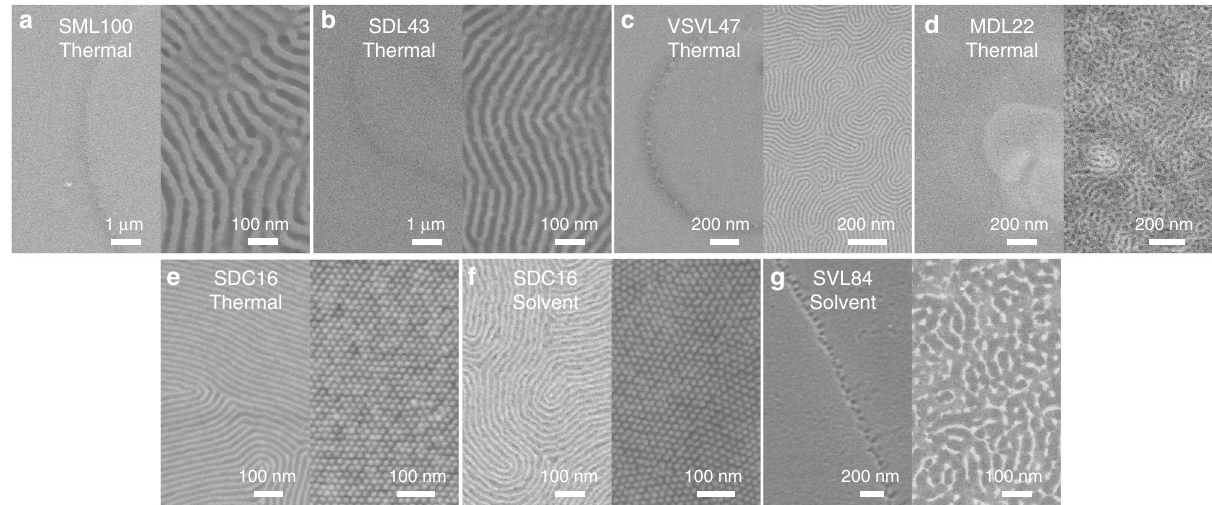
Fig. 2 Morphology differences of various annealed BCP fi lms with and without the fi ltered plasma treatment. Top view SEM images of thermally annealed PS- b -PMMA ( a , SML100), lamellar PS- b -PDMS ( b , SDL43), P2VP- b -PS- b -P2VP ( c , VSVL47), PMMA- b -PDMS ( d , MDL22) and cylinder PS- b -PDMS ( e , SDC16), and solvent annealed ( f ) SDC16 and ( g ) PS- b -P2VP (SVL84) without (left) and with (right) the fi ltered plasma treatment. The annealed BCP fi lms without the plasma treatment showed ( a – d and g , left) a terraced structure from incommensurate thickness of the parallel lamellae and ( e and f , left) parallel cylindrical microdomains. On the other hand, perpendicular orientation of lamellae ( a – d and g , right) and cylinders ( e and f , right) were obtained on the surface of various BCP fi lms with fi ltered plasma